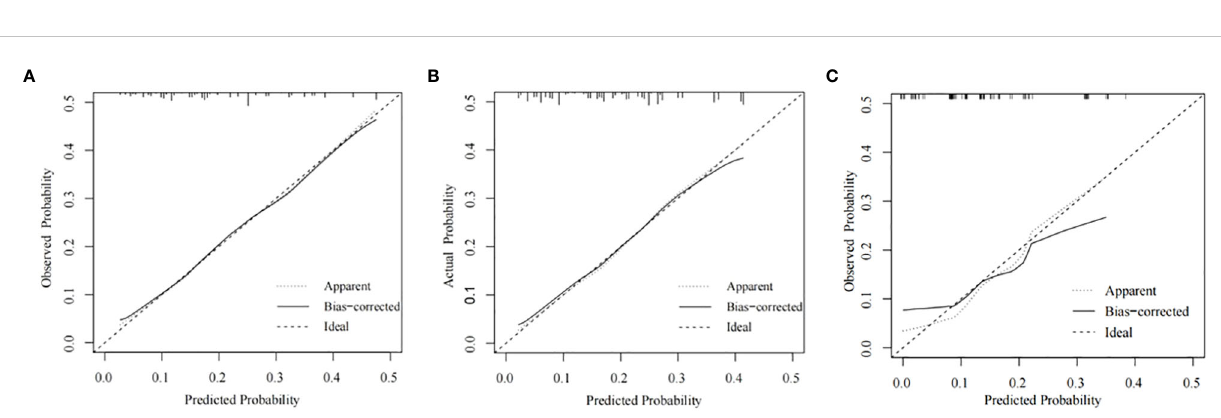
FIGURE 5 Calibration plots for the nomogram. Calibration plots for the nomogram in the training cohort (A) , the internal validation cohort (B) , and the external validation cohort (C)